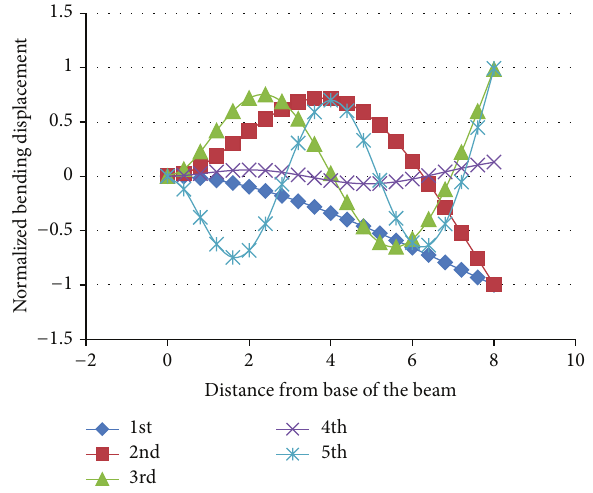
Figure 11: DSM bending mode shapes.